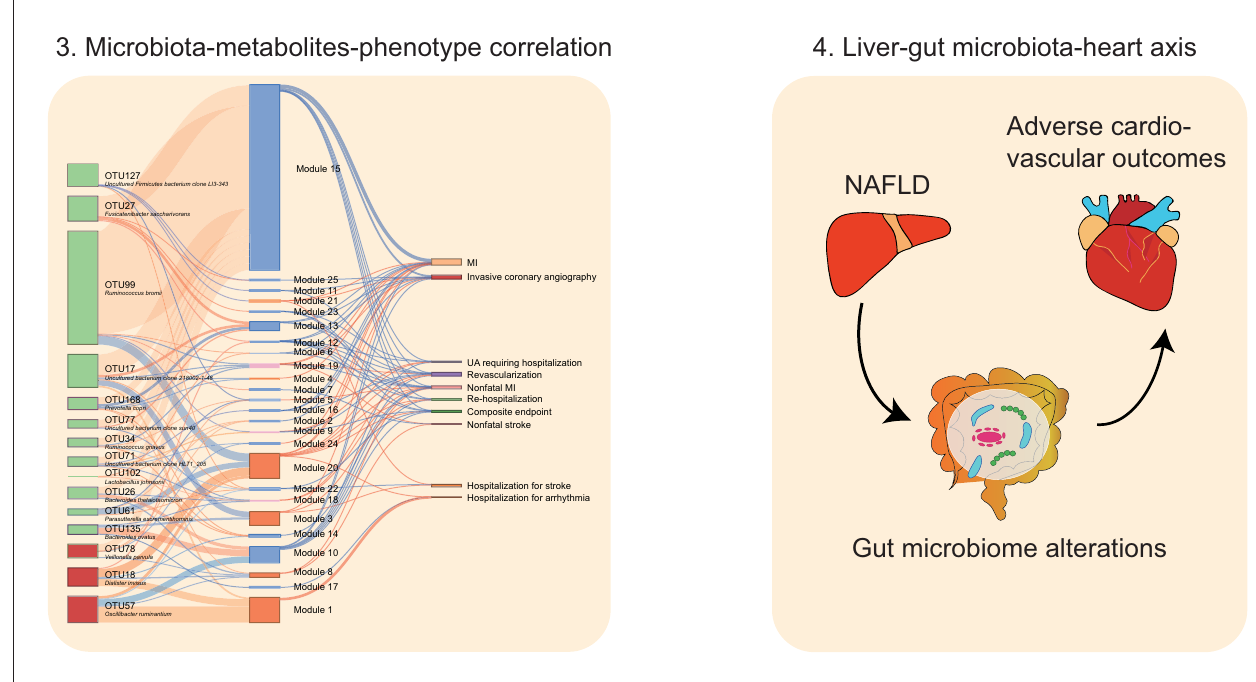
valuePLN1322:TG(20:5(5Z,8Z,11Z,14Z,17Z)/O-18:0/20:5(5Z,8Z,11Z,14Z,17Z))PLN1329:TG(20:0/20:0/18:2(9Z,12Z))PLN1376:PC(24:0/24:1(15Z))PLN2149:(3b,24R,25x)-26-Benzoyloxystigmast-5-ene-3-olPLN2150:TG(20:1(11Z)/20:1(11Z)/20:1(11Z))PLN2160:TG(20:1(11Z)/22:5(4Z,7Z,10Z,13Z,16Z)/20:1(11Z))PLN2170:TG(22:1(13Z)/15:0/O-18:0)PLN2220:TG(22:2(13Z,16Z)/20:0/O-18:0)PLN2221:Glycerol trinonadecanoatePLN2222:TG(20:1(11Z)/15:0/O-18:0)PLP3213:(3E,5Z,8Z)-Tetradecatrienoyl-CoAPLP3214:TG(12:0/10:0/8:0)PLP377:2,4,12-Octadecatrienoic acid isobutylamidePLP406:alpha-CadinolPLP5713:Stearic acidPLN1323:5-Methyl-5-pentacosanolPLN1843:BenzbromaronePLN2184:Pentosan PolysulfatePLN2230:5-Diphosphoinositol pentakisphosphate compoundsOrganic oxygen PLP215:(Z)-9-Cycloheptadecen-1-onePLP2743:Hexanal dihexyl acetalPLP14:D-(+)-MannosePLP1283:Thermophillin PLP5452:1,2,5-Trimethyl-1H-pyrrolePLP3212:Coproporphyrinogen IIIPLP214:AmbronidePLP209:2-Pentadecylfuran hexasulfideOthersBenzenoidsOrganoheterocyclic PLP3245:Epitheaflagallin 3-O-gallatePLP2636:Methyl 2-furoatePLN1303:ChlorothiazidePLP6057:N-(14-Methylhexadecanoyl)pyrrolidine PLP5475:N-methylvalinePLP4856:VigabatrinPLN1842:2,5-Dichloro-4-oxohex-2-enedioatePLP1321:2,3-Diaminosalicylic acid PLN2232:6-Mercaptopurine ribonucleoside 5'-diphosphatePLN111:Di-2-propenyl